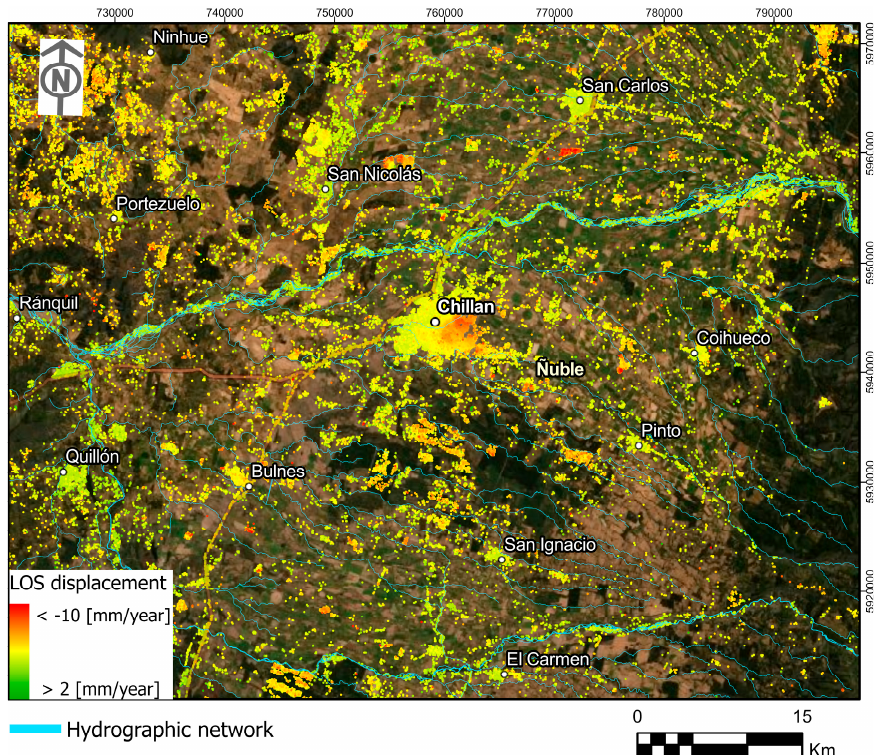
Figure 3. Overall view in study area, distribution of Persistent Scatterers Interferometry (PSI) and LOS displacement map [mm/year], background ESRI maxar source. LOS displacement map [mm/year], background ESRI maxar